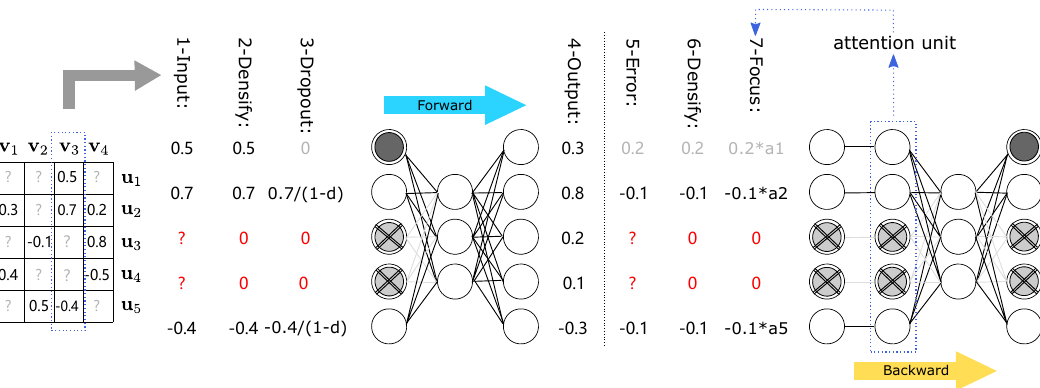
Figure 2. A two-layer Attention Collaborative Autoencoder (ACAE). ( Left ) Sparse forward propagation with input dropout. ( Right ) Attention back propagation, where errors of missing values are turned into zero and other errors are reweighted by attention